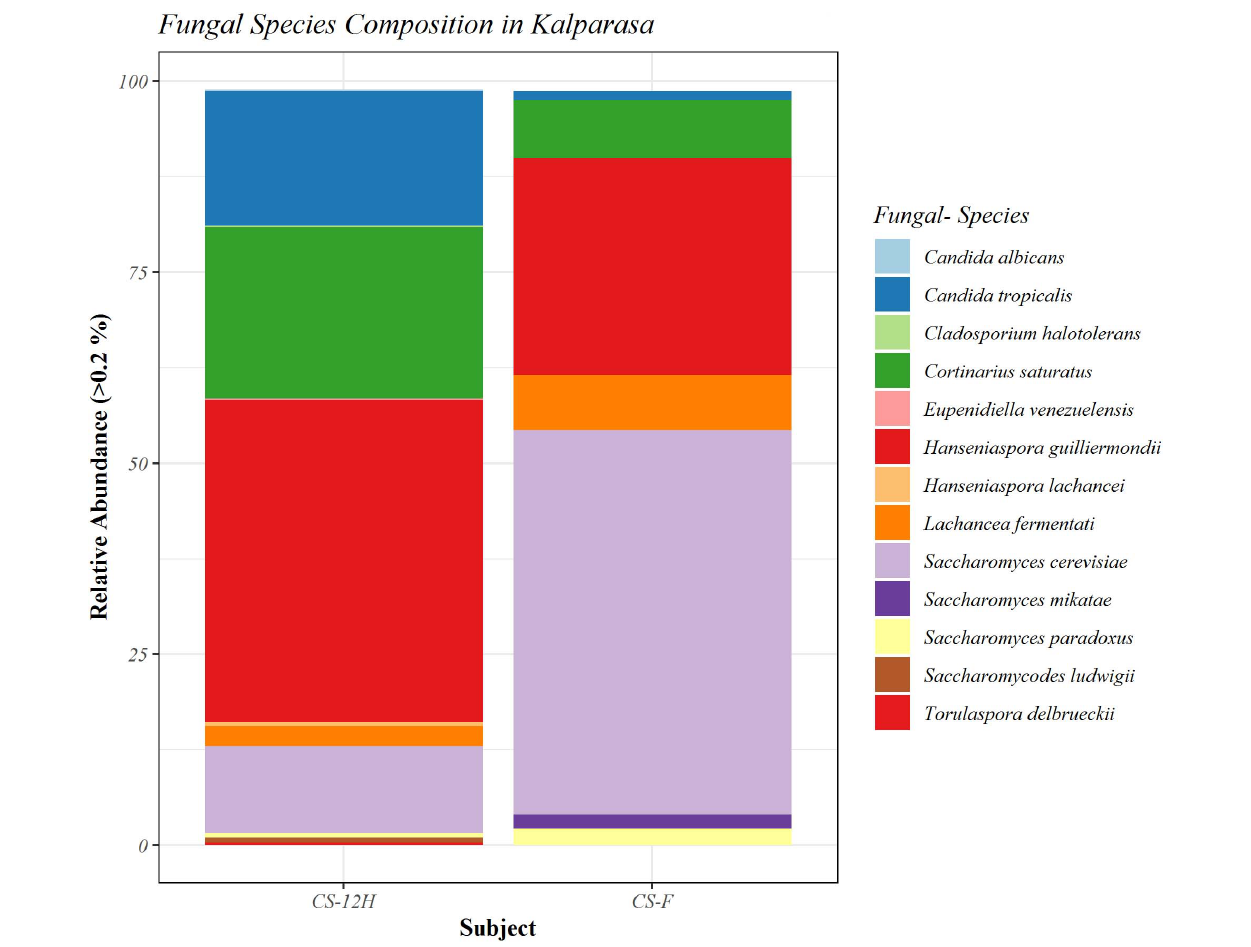
FIGURE 5 | Bar plot representing relative abundance percentage ( > 0.2%) of detected fungal species in fresh (CS-F) and 12-h fermented (CS-12H) Kalparasa